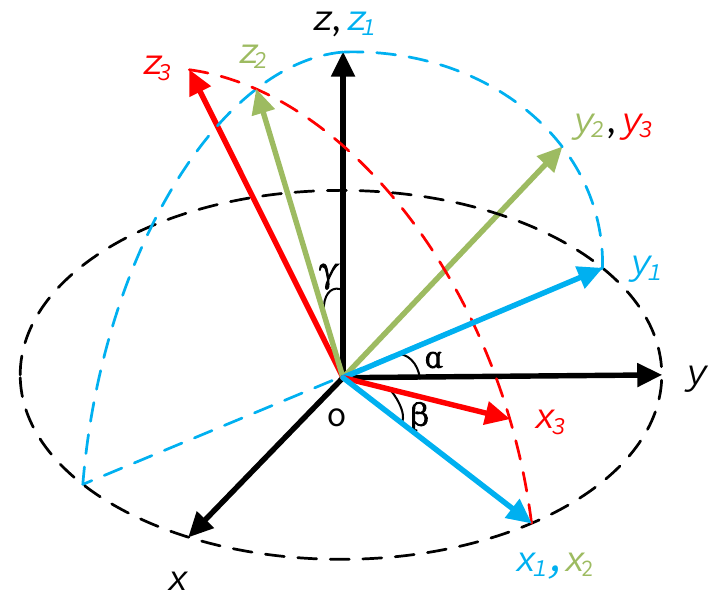
Figure 2. The diagram of Euler’s rotation.